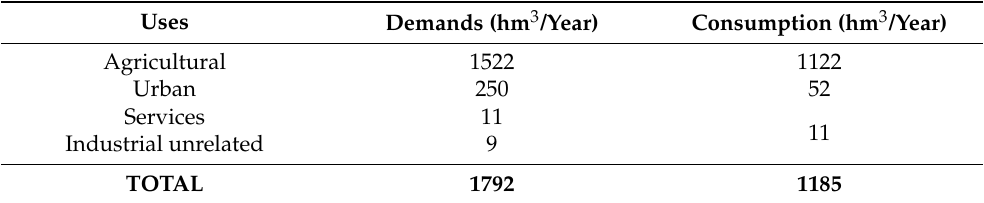
Table 2. Demands and consumption of water of the SRB. Source: own elaboration based on [32,40].